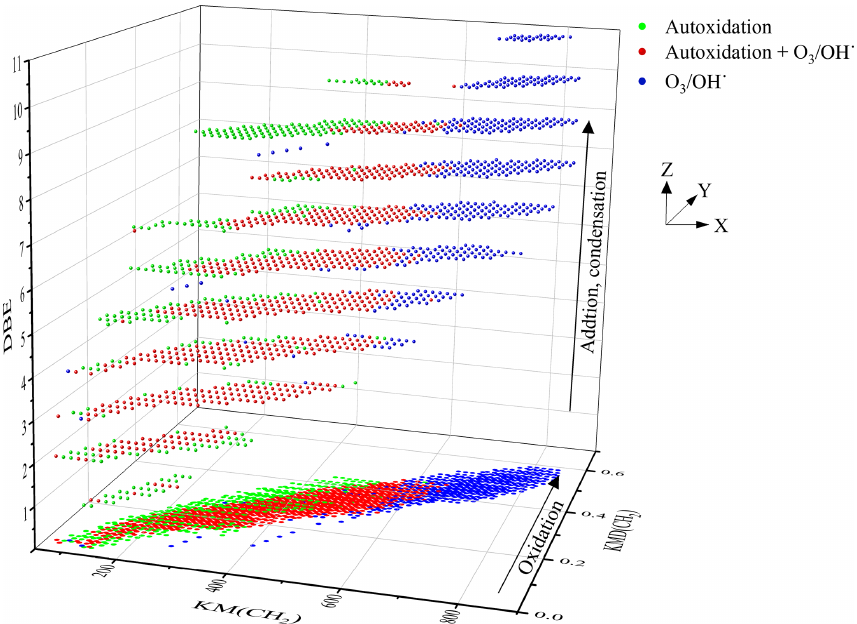
Figure 2. All the chemical products, resulting from limonene oxidation by ozonolysis/photooxidation and autoxidation gathered in the form of a Kendrick diagram correlated to the DBE (with projection on the XY plane). Green dots: new chemical products from autoxidation experiments (JSR), red dots: common to the three modes of oxidation, blue dots: chemical products with molecular formulae not observed in